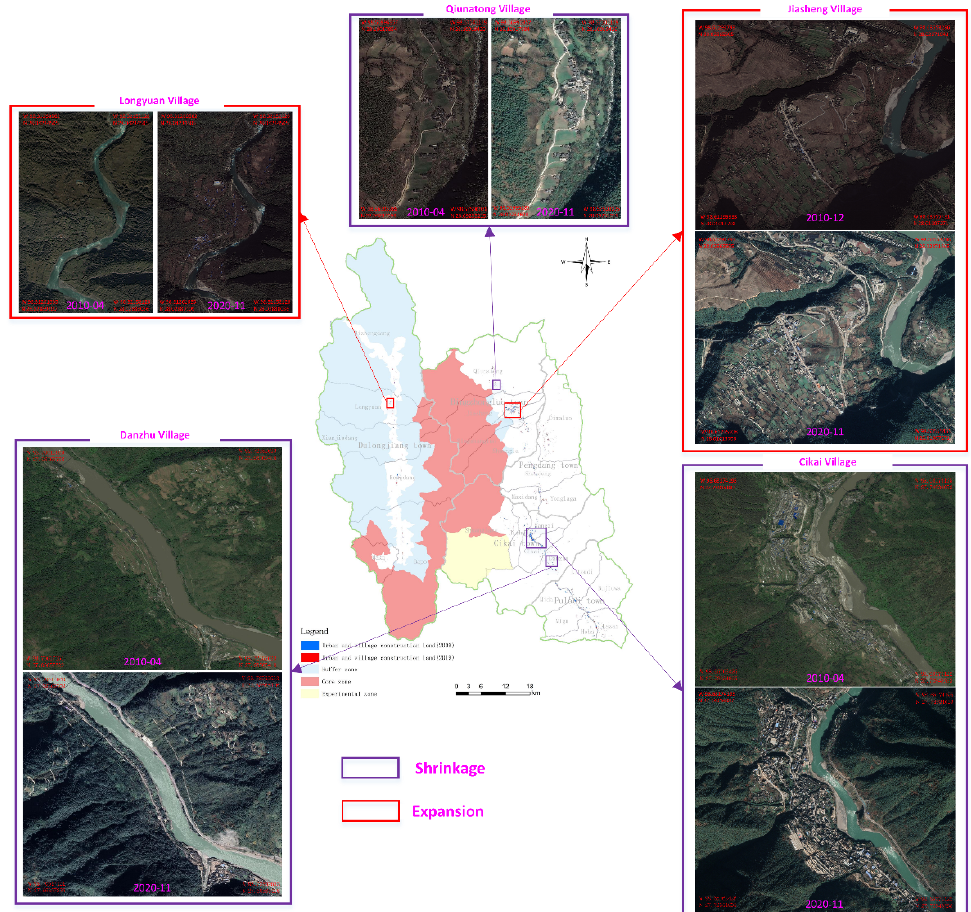
Figure 5. Remote sensing image validation of shrinking and expanding villages undergoing large changes.